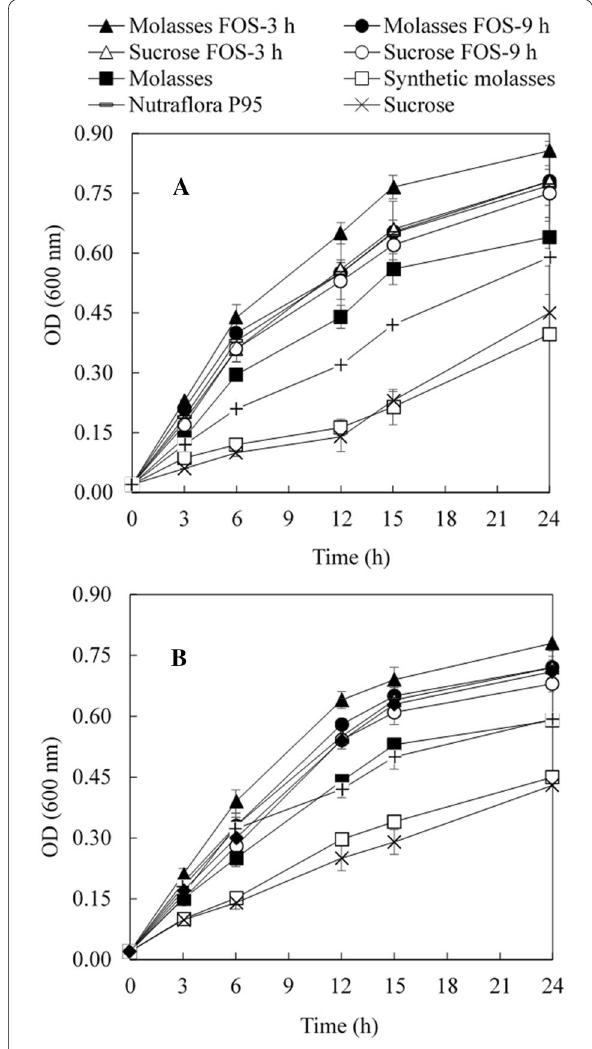
Fig. 6 Representative growth curves of two probiotics in the presence FOS and non-FOS sugars. A Bacillus H 57, B L. casei QUT